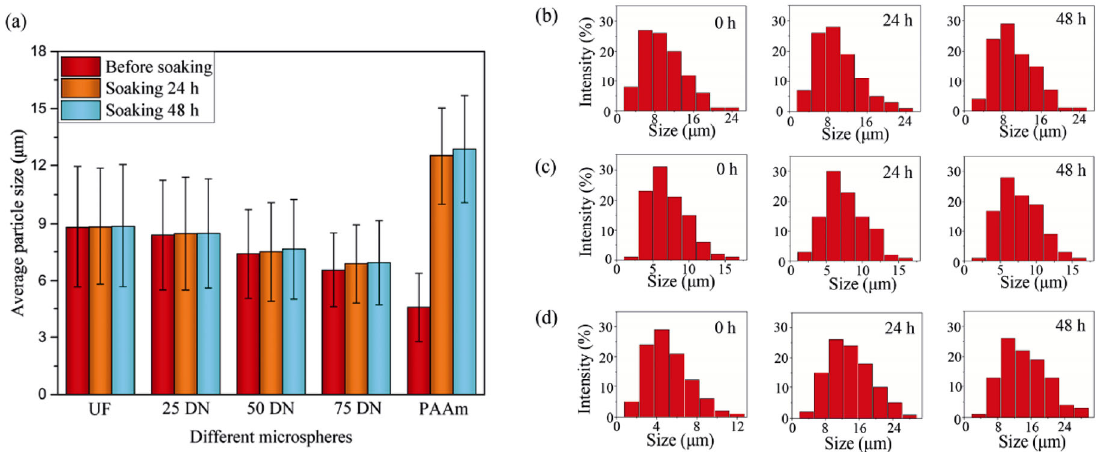
Fig. 4 Particle size of microspheres with different soaking time. (a) Average size of different microspheres. (b–c) Size distribution: (b) UF, (c) 75 DN, and (d)